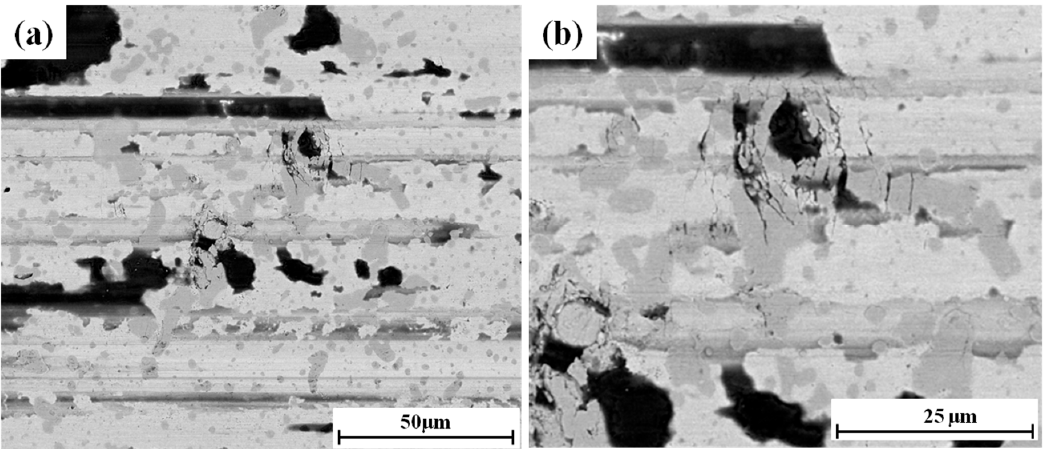
Figure 9. ( a ) Worn surface at the center of the wear scar after 72 × 10 3 cycles under the normal load of 35 N. ( b ) Higher magnification BSE image of ( a ).